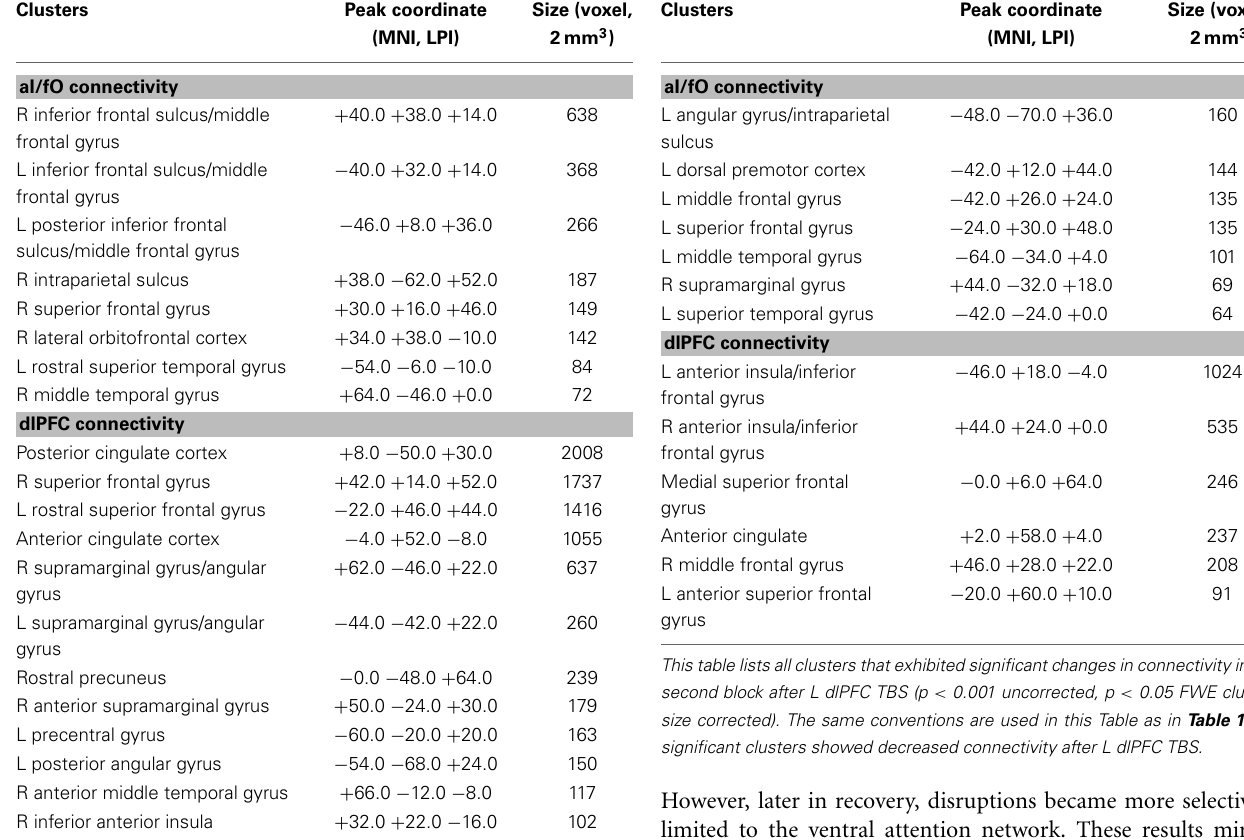
Table 1 | Clusters showing increased connectivity after L aI/fO TBS. Clusters